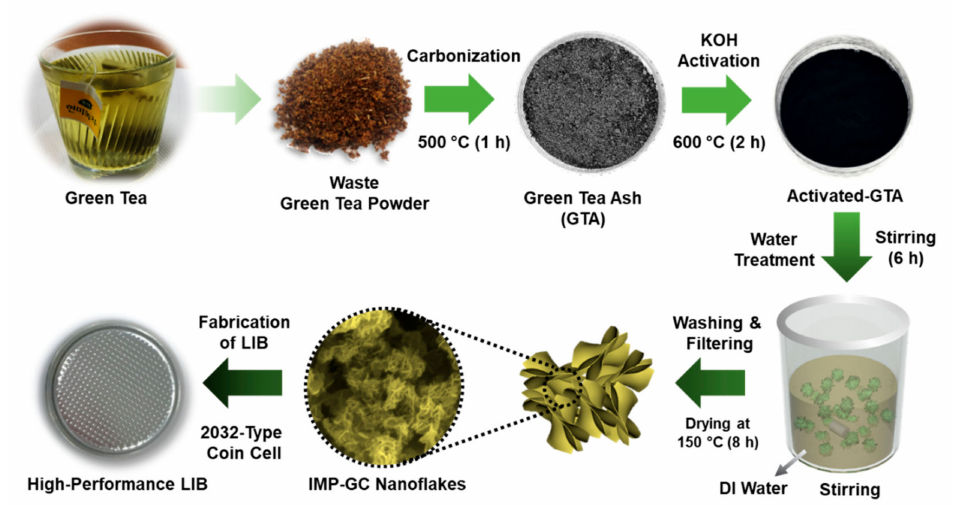
Figure 1. Schematic illustration of the synthesis procedures for the preparation of interconnected mesoporous graphitic carbon (IMP-GC) nanoflakes using a biomass carbonaceous resource derived from green-tea waste via potassium hydroxide (KOH)